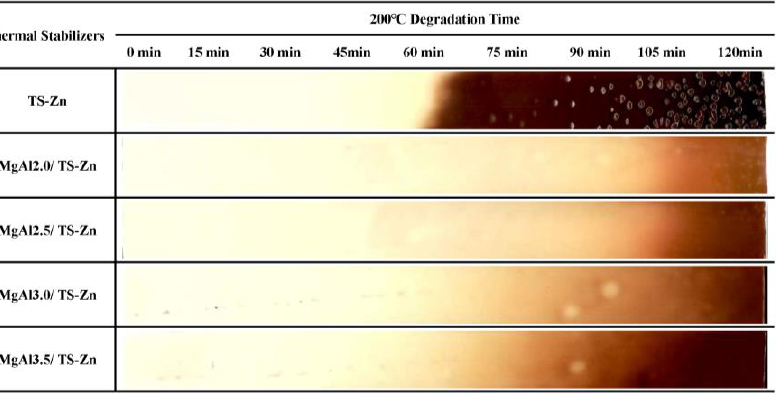
Figure 7. The molar ratio of Mg/Al in LDHs affects the thermal stability of PVC in an oven-aging test.